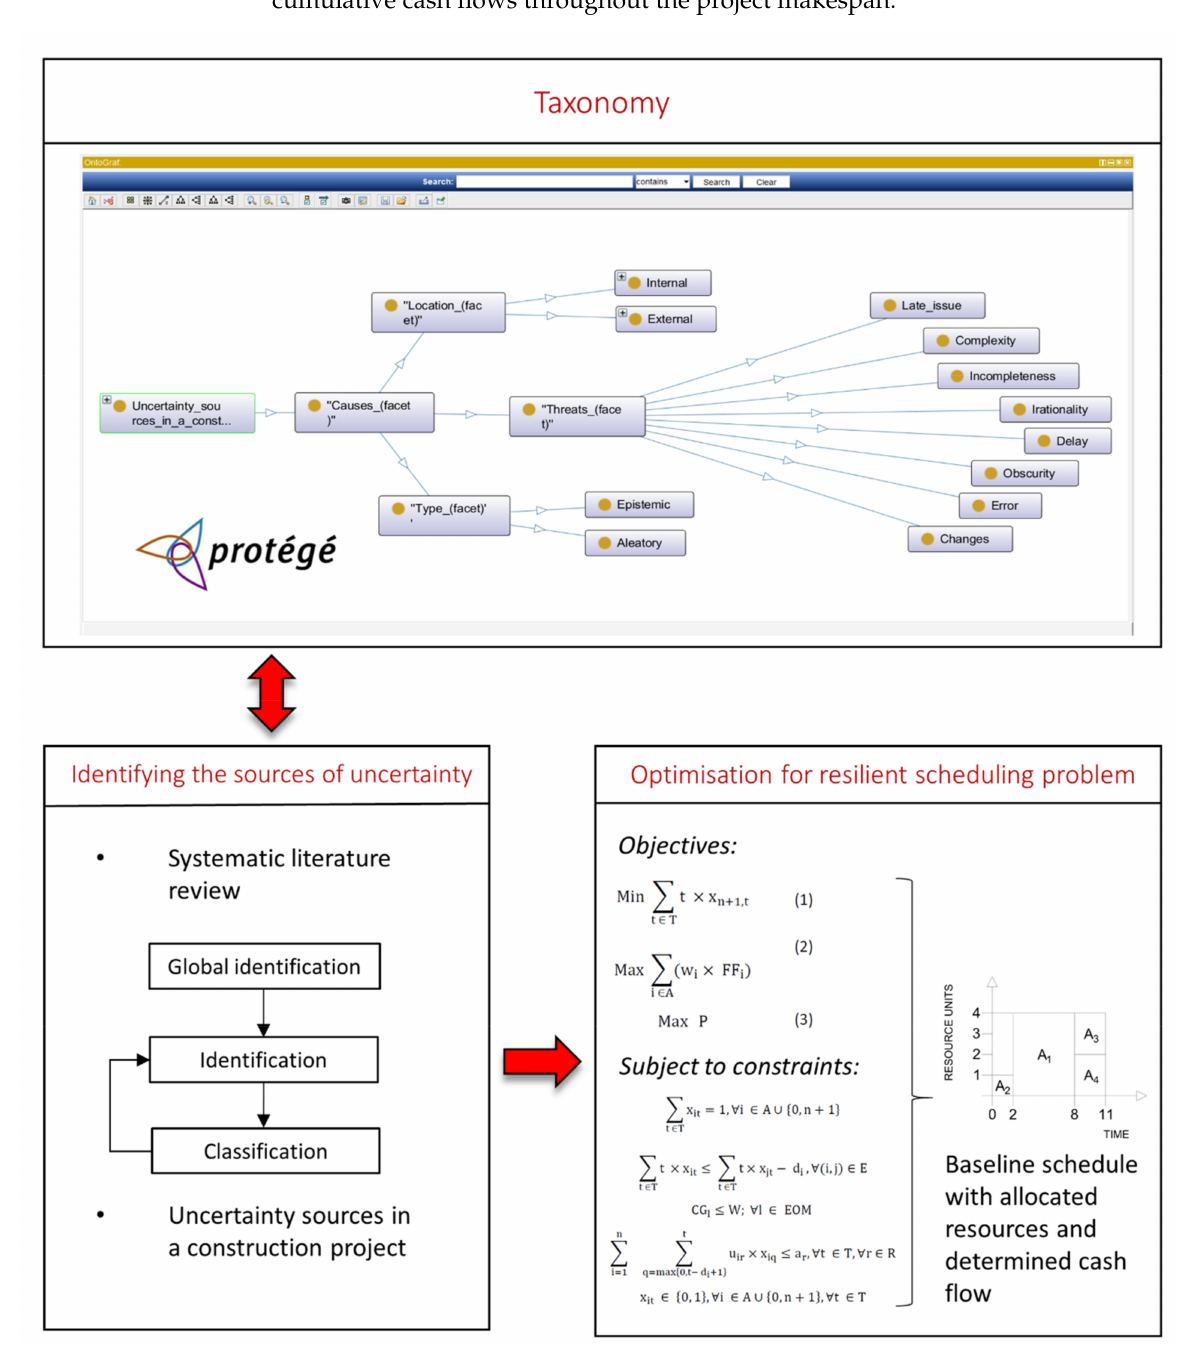
Figure 2. Layout of the proposed resilience procedure for uncertainty management in construction